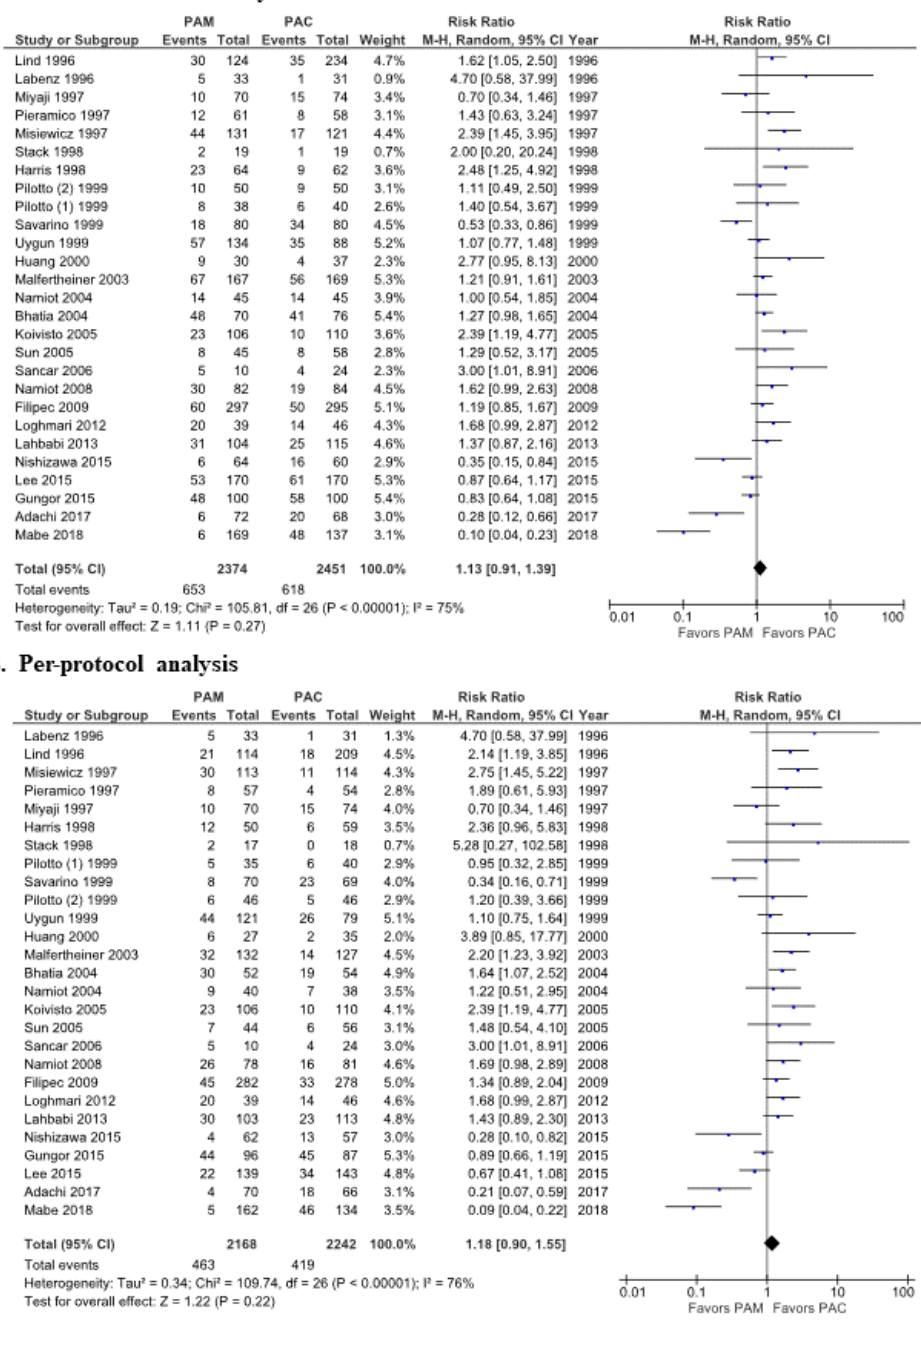
Figure 2. Forest plots of overall eradication rates between PAM therapy and PAC therapy in all eligible trials with intention-to-treat analysis ( A ) and per-protocol analysis ( B ) in the random-effects model. The relative risk (RR) for successful eradication between PAC therapy and PAM therapy was similar in the intention-to-treat (ITT) analysis ( A ) and the per-protocol (PP) analysis ( B ). Abbreviations: CI, confidence interval; PAC, proton pump inhibitor (PPI)/amoxicillin/clarithromycin; PAM, PPI/amoxicillin/metronidazole.